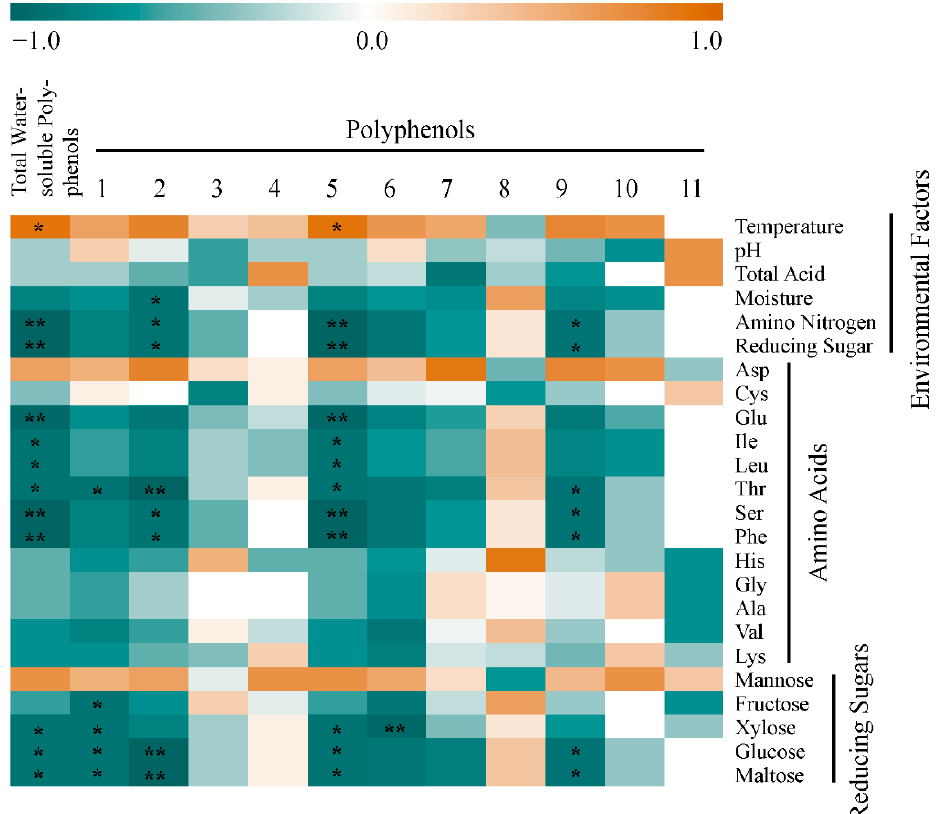
Figure 3. Spearman correlation analysis heat map between polyphenols and environmental factors during the smoking process of Shanxi aged vinegar (red and green indicate positive correlation and negative correlation, respectively, and the shade of color indicates the size of the correlation coefficient; * p < 0.05; ** p < 0.01).